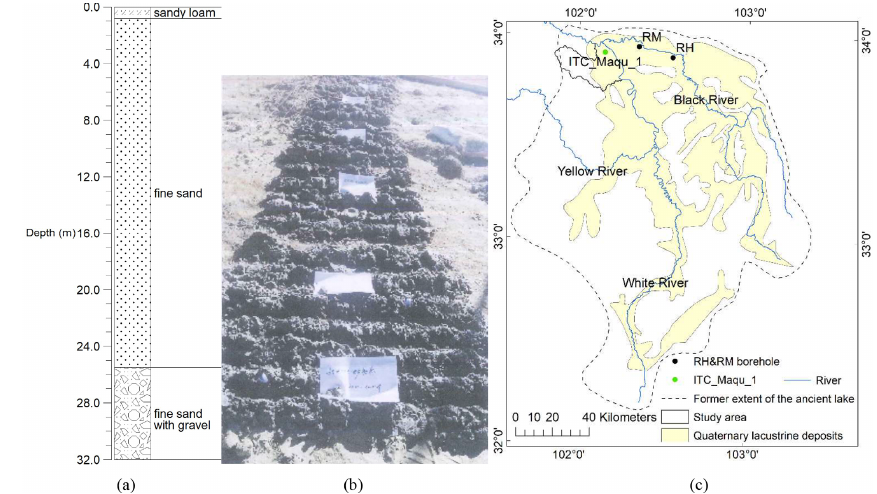
Figure 6. Borehole information: (a) the core lithology of borehole ITC_Maqu_1, (b) a picture of the core sediment when the borehole was drilled, (c) location of boreholes RM and RH (after Chen et al., 1999).